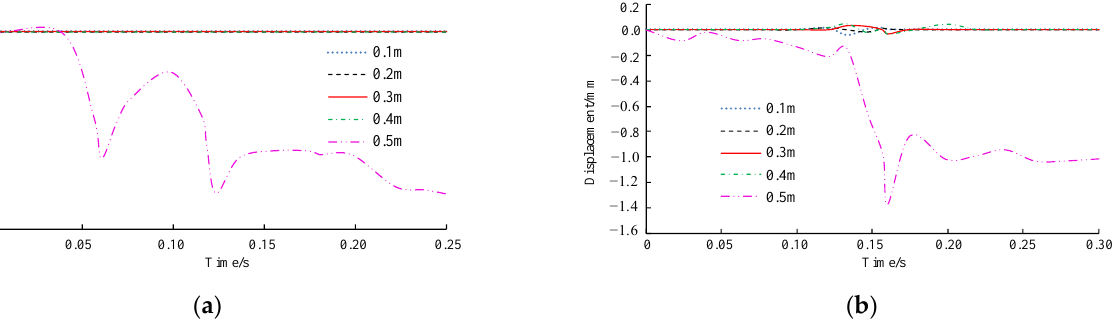
Figure 21. Displacement time history curve of the 6th layer. ( a ) Displacement at the top plate; ( b ) Displacement at the base.